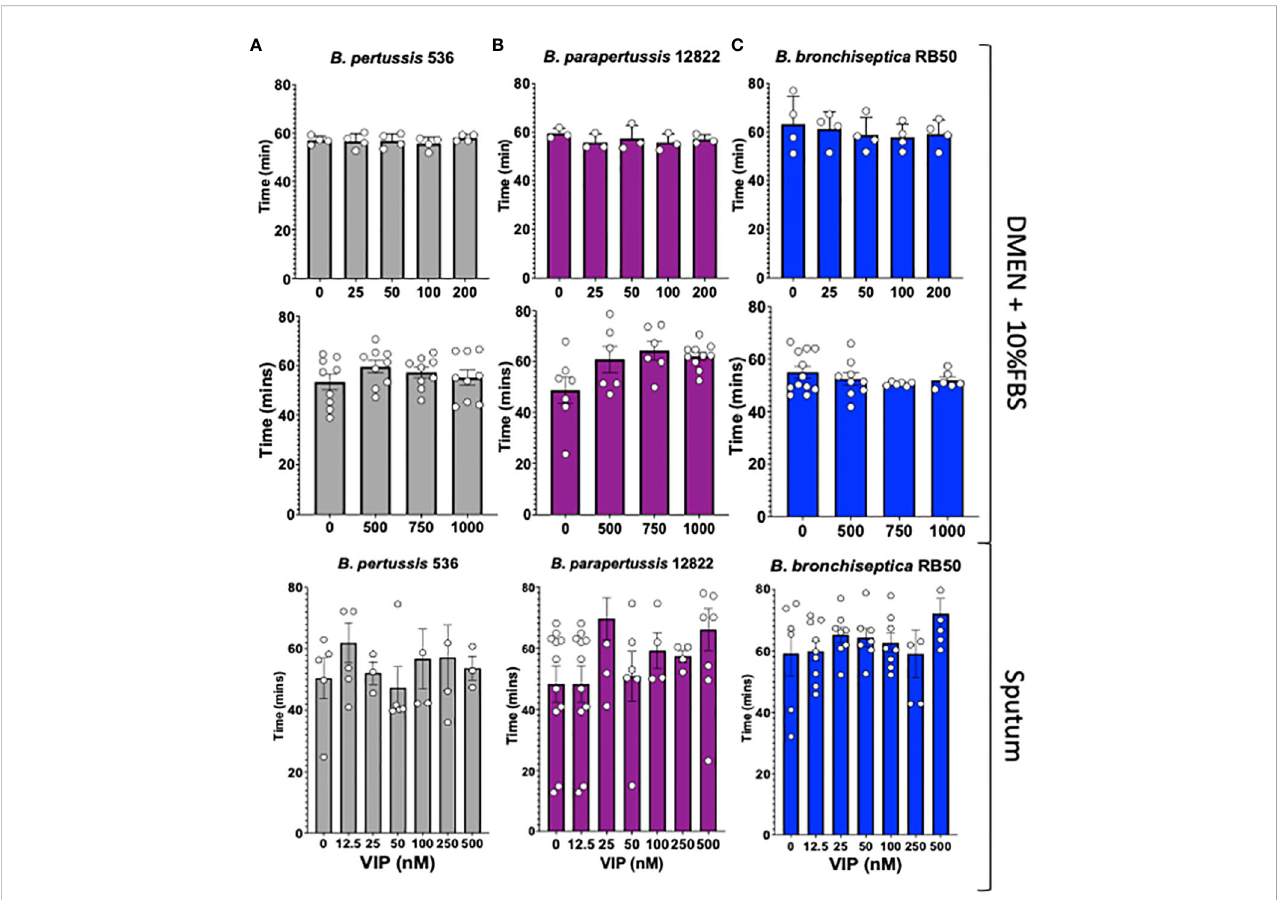
FIGURE 1 VIP does not kill nor affect the growth of classical Bordetella spp. In vitro cultures of B. pertussis strain 536 in grey (A) , B. parapertussis strain 12822 in purple (B) , and B. bronchiseptica strain RB50 in blue (C) were inoculated on a 96-well plate using DMEM supplemented with 10% FBS, or synthetic sputum media, containing a series of increasing VIP concentrations (between 0 to 1000nM). The plate was incubated in a Biotek Synergy H1 ® for 12 hours to monitor bacterial growth by optical density (OD 600 ). Each symbol shows the mean of a single biological replicate containing 3 technical replicates. Duplication time was calculated for each case during the exponential phase. Two-way ANOVA analysis was performed to evaluate statistical differences. N = 3-10, with 3 technical replicates for each